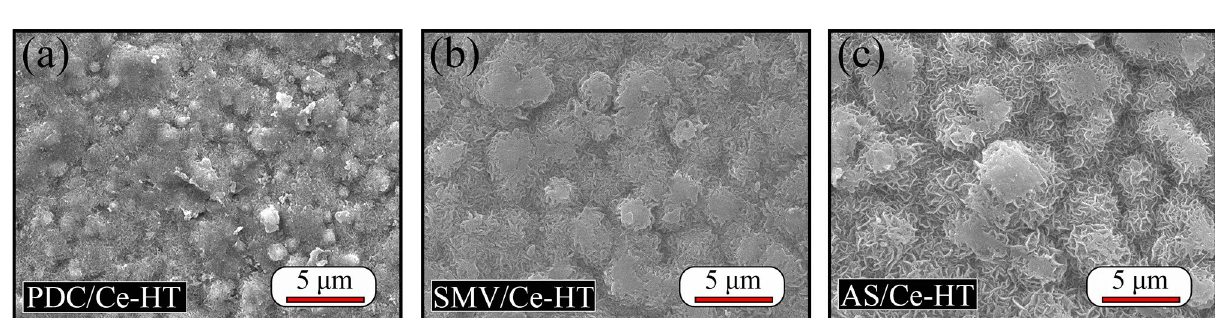
Figure 8. The cross-sectional SEM images and corresponding EDS mappings of ( a ) PDC/Ce, ( b ) SMV/Ce and ( c ) AS/Ce specimens.